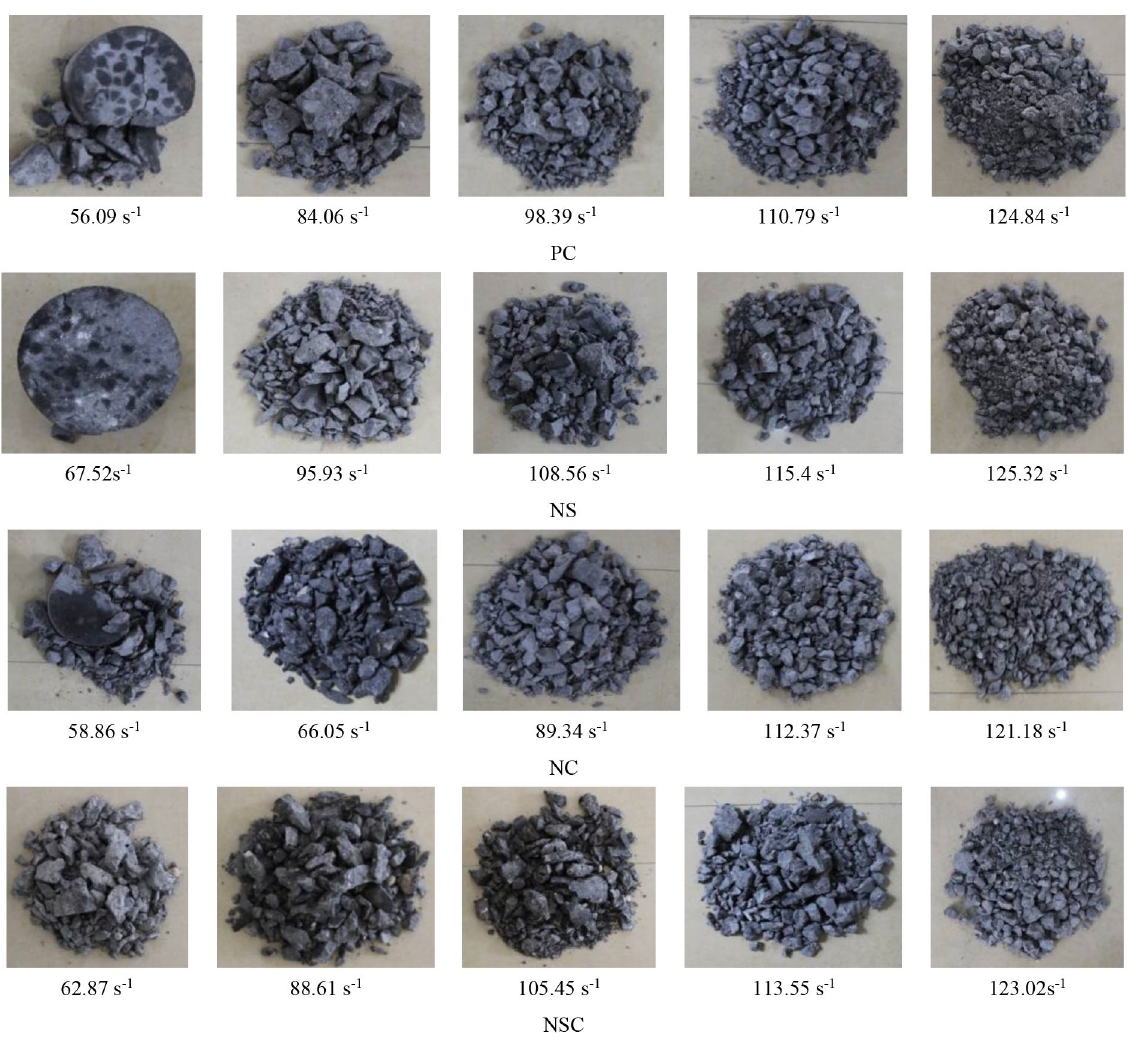
Figure 19. Failure mode of